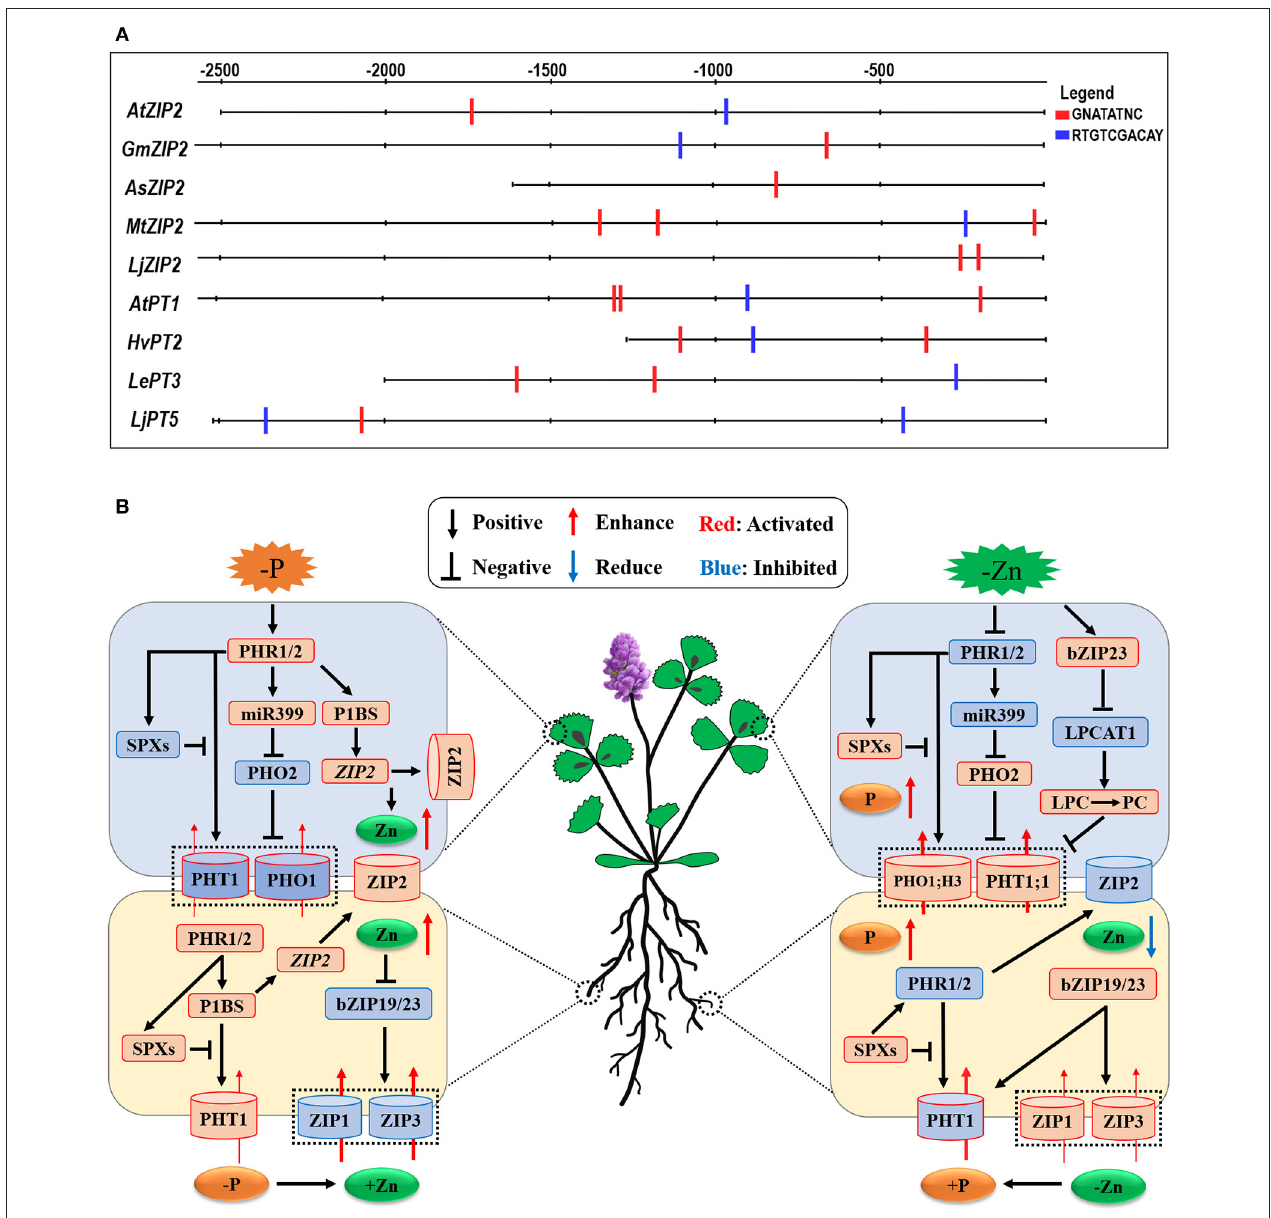
FIGURE 3 | Schematic representation of the cross-talk between Pi and Zn nutrients and the potential linkers involved in the interaction between Pi and Zn nutrient homeostasis in plants. (A) the potential Pi- and Zn-deficient cis -regulatory elements present in the promoter regions of PHT1 family and ZIP family genes from plants. P1BS-motif (GNATATNC), which is the target site of PHR1 in plants, was screened in the promoter region of plant PHT1 and ZIP genes by DNA-pattern-matching analysis (http://rsat.ulb. ac.be/rsat/). The GNATATNC motif is found in the promoter region of AtZIP2 (in Arabidopsis thaliana ), GmZIP2 (in Glycine max ), AsZIP2 (in Astragalus sinicus ), MtZIP2 (in Medicago truncatula ), and LjZIP2 (in Lotus japonicus ), while the promoter sequences of AtPT1 (in Arabidopsis thaliana ), HvPT2 (in Hordeum vulgare ), LePT3 (in Solanum lycopersicum ), and LjPT5 (in Lotus japonicus ) further contain the ZDRE motif (RTGTCGACAY), which is activated by the bZIP19/23 transcription factors during Zn deficiency. (B) Under Pi deficiency, the PHT1 and PHO1 genes are activated to be essential for Pi uptake and accumulation in plants through the Pi regulatory-signaling pathway (PHR1-miR399-PHO2); moreover, the ZIP2 subfamily genes, belonging to the plant ZIP gene family, are transcriptionally induced via the activated PHR1 transcription factor binding to the P1BS (GNATATNC) sequences found in the promoter regions of their genes (see A ). On the other hand, Zn deficiency activates the bZIP19/23 transcription factors, and bZIP19/23-mediated Zn regulatory pathway induces the ZIP gene family transporters to promote Zn uptake and homeostasis. On the other hand, LPCAT1 ( Lyso-PhosphatidylCholine AcylTransferase 1 ), PHT1;1 , and PHO1;H3 are transcriptionally upregulated in a bZIP19/23-dependent manner during Zn deficiency. The black arrows and flat-ended lines refer to the positive and negative interactions, respectively. The red and blue arrows represent the increased and decreased element contents; accordingly, the red and blue modules indicate the activated and inhibited processes in plants.